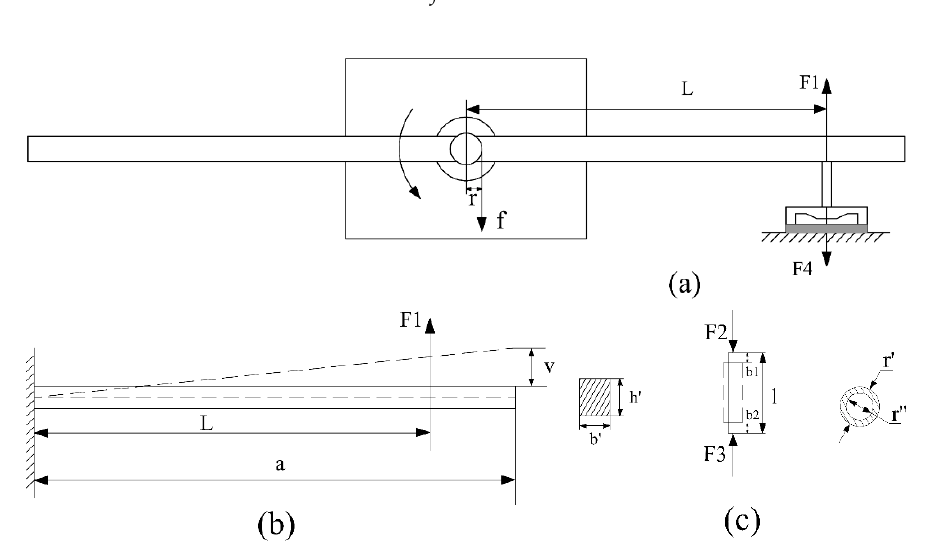
Figure 2. ( a ) Schematic of the measurement mechanism by torque balance; ( b ) Applied force and induced deflections of the lever arm; ( c ) Applied force and induced deflections of the sensor probe.